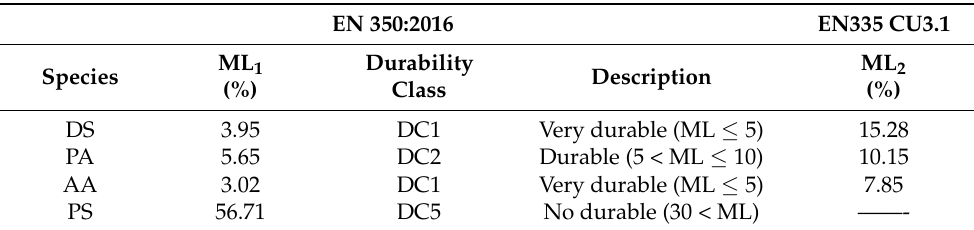
Table 4. Mean mass loss (ML 1 ) for DS, PA, and AA species after the durability test according to standard EN 350:2016 and mean mass loss (ML 2 ) according to standard EN335